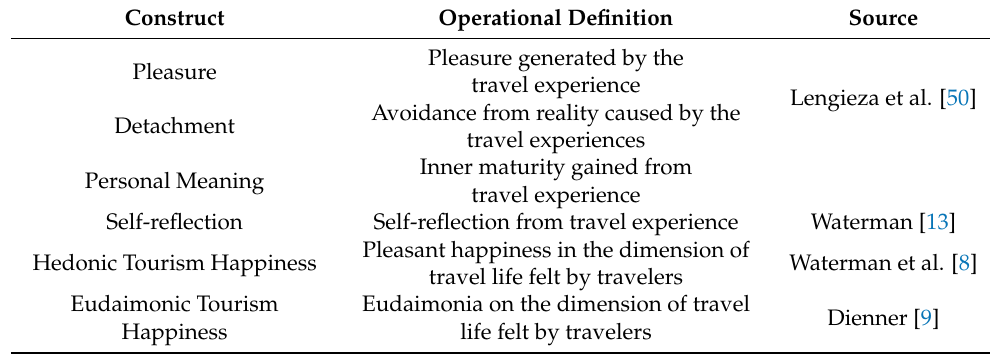
Table 3. Operational Definitions of Major